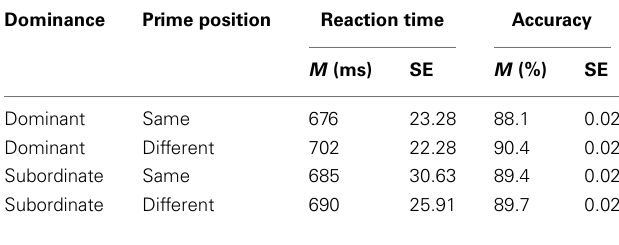
Table 2 | Mean RT and accuracy of each experimental condition.